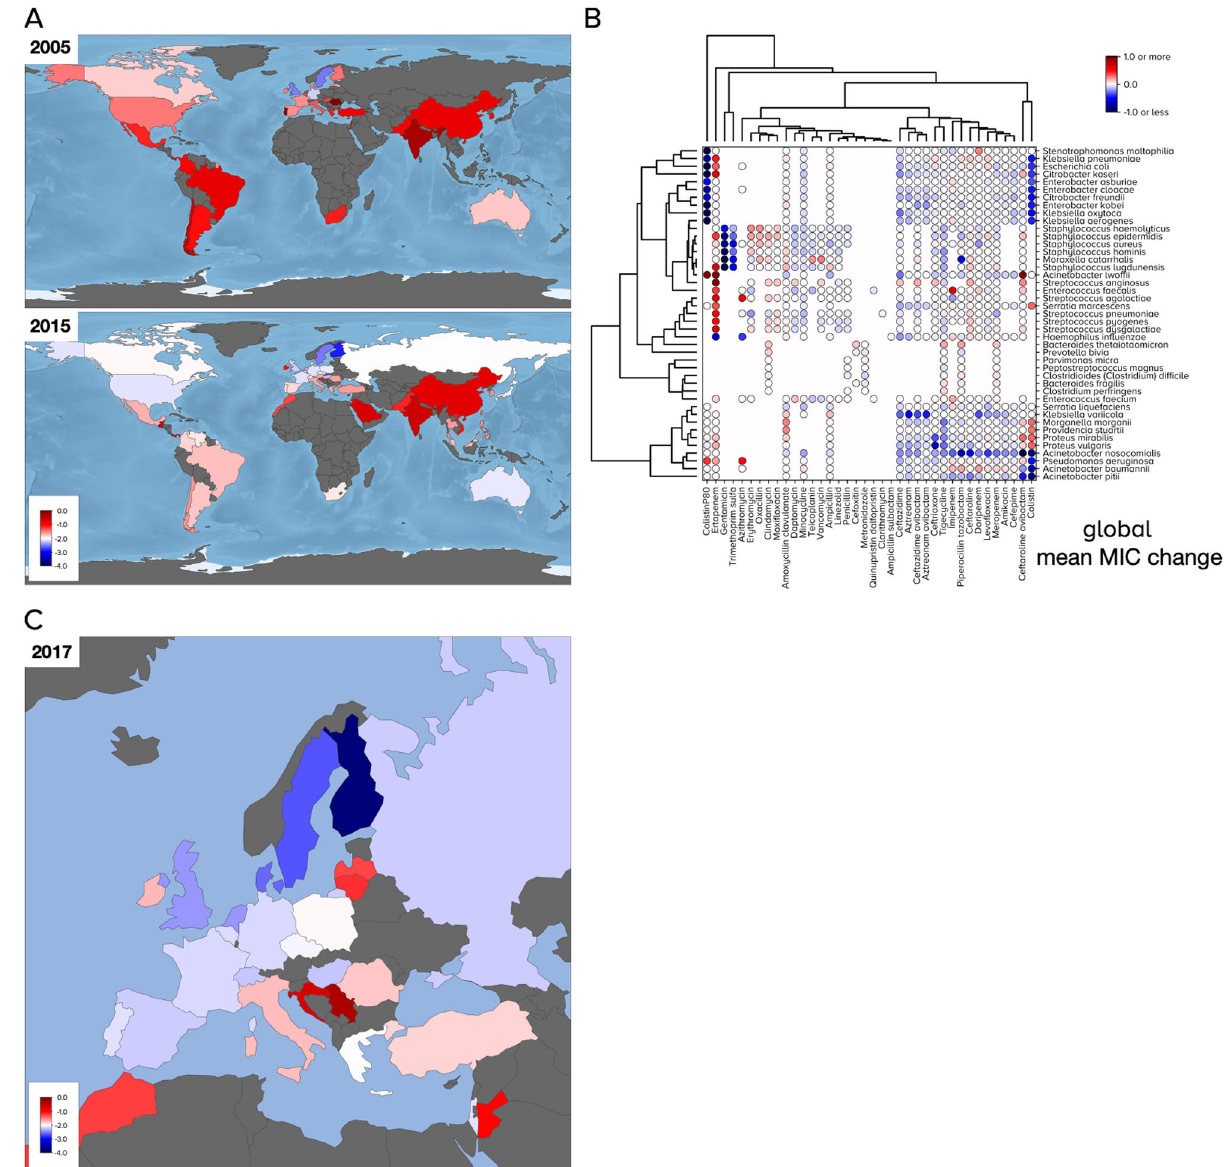
Fig. 5 Coarse changes in mean MIC (minimal inhibitory concentration) for all pathogen-antibiotic (PA) pairs: some decreases with increases in Asia. A The distribution of mean MICs for PA pairs aggregated globally: a potential reduction is apparent from 2005 to 2015 in some countries with increases in India and China. B The slope of a linear regression attempts to predict mean MIC changes globally for all PA pairs and is shown as a dot. A blue-to-red colour scale indicates normalised log 2 MIC change per year: red is + ve, blue is -ve, light grey is no change, grey countries in A and C have insuf fi cient data, as do white regions in B. Dots are clustered into PA pairs of similar change, indicative of a global motif of predicted increases and decreases; the same analysis using European-only data is Supplementary Fig. 15A. C European MICs aggregated across all PA pairs in 2017 shown by country indicate possible differences between eastern and western Europe. Colourbars in A and C show normalised log MIC 2